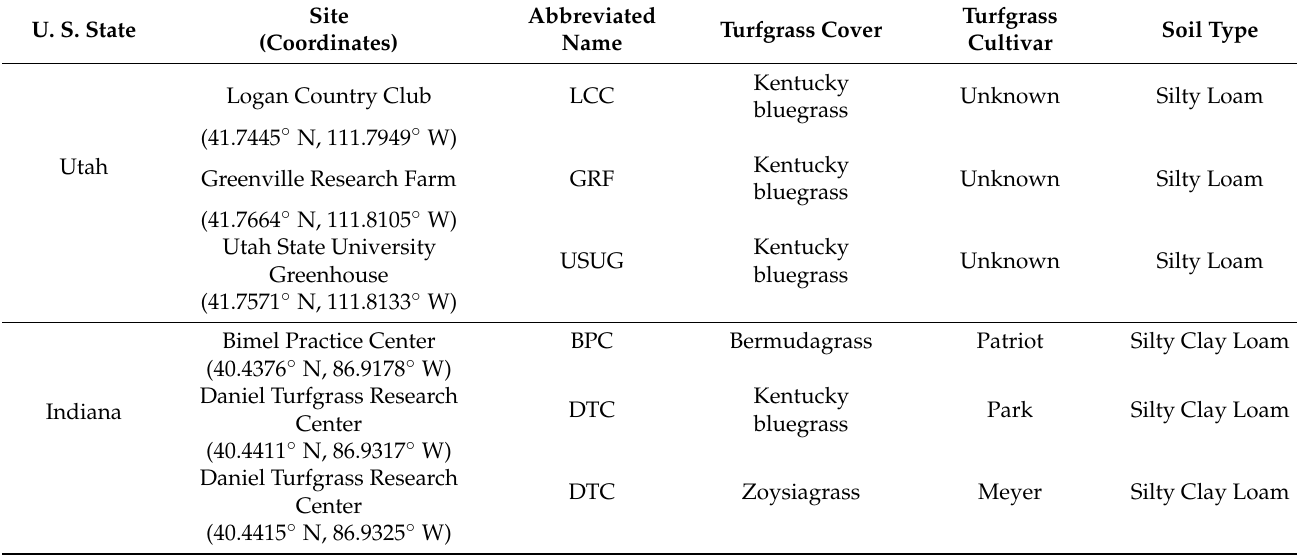
Table 1. Predominant turfgrass cover and soil types associated with billbug larval collection locations in Utah and Indiana. U. S.